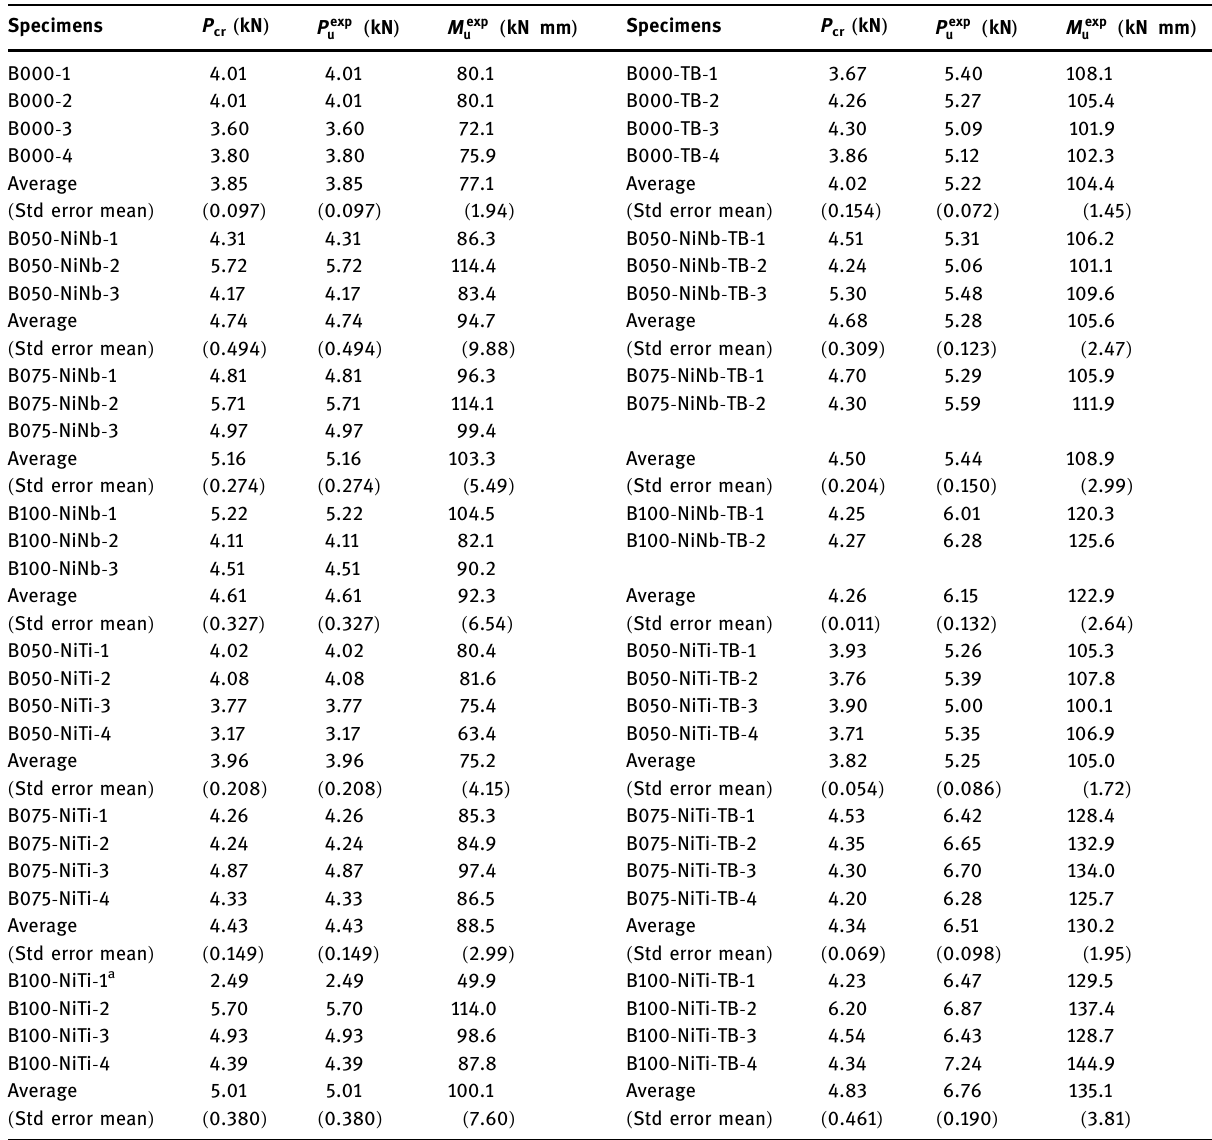
Table 2: Summary of the test results for the beam specimens with and without tensile wires